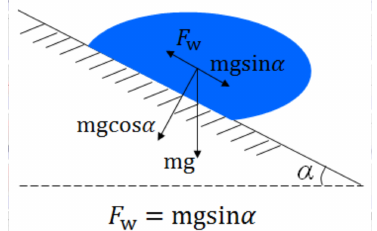
Figure 1. Illustrations of the sliding angle and the wall adhesion force. α is the sliding angle and F w is the wall adhesion force.